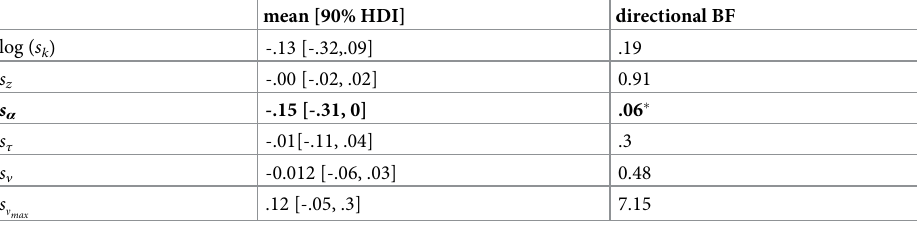
Table 5. Tyrosine related changes in group-level means of the DDM s for the temporal discounting task data. We report mean and 90% HDIs for the ‘shift’ parameters and Bayes Factors for directional effects (tyrosine > placebo). � denotes strong evidence (dBF > 10 / < .1) for a tyrosine-related effect on the respective shift parameter s α